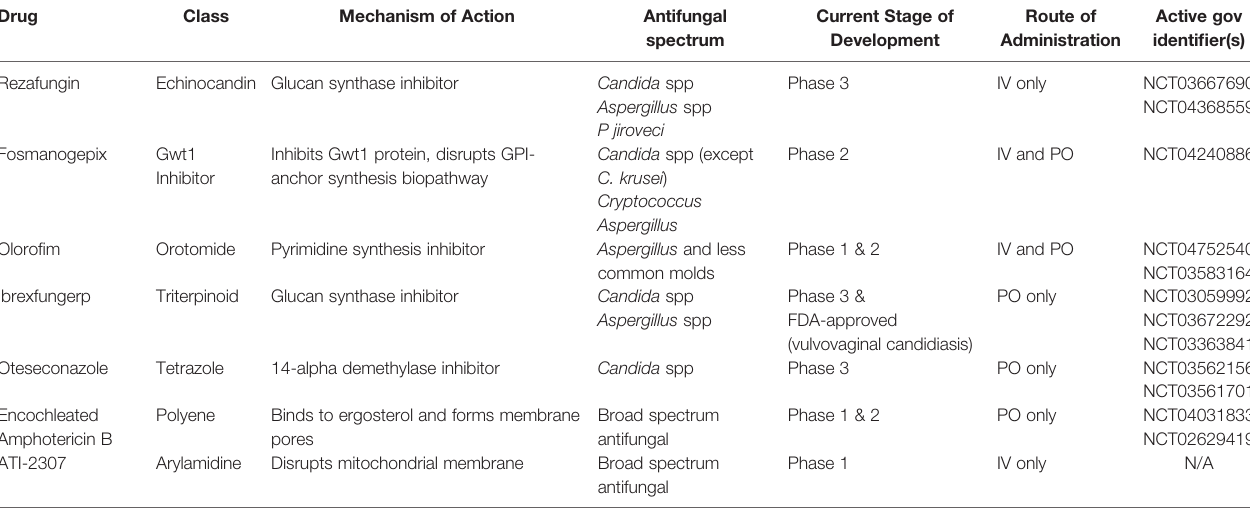
TABLE 1 | Summary of